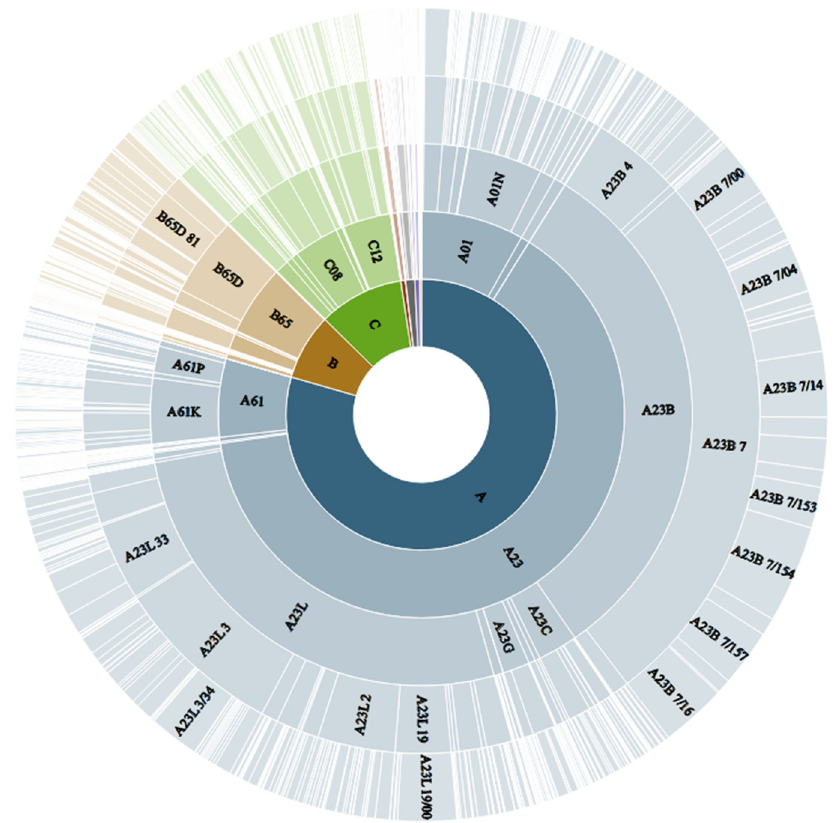
Figure 3. IPC codes derived from patents database.